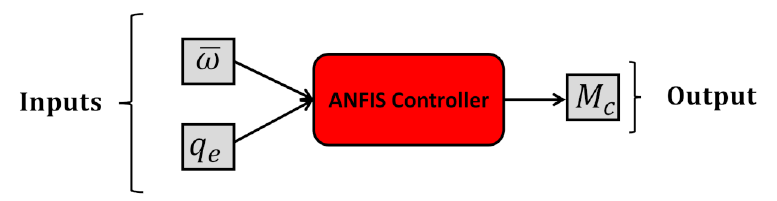
Figure 2. Block diagram of the ANFIS